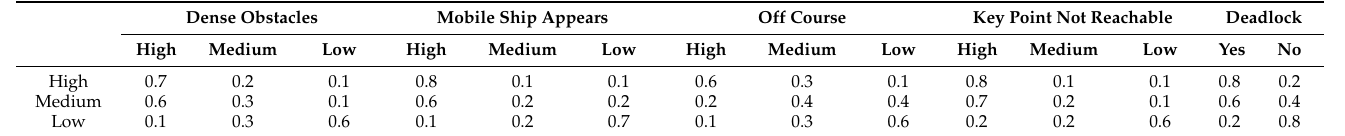
Table 2. Conditional Probability Table.